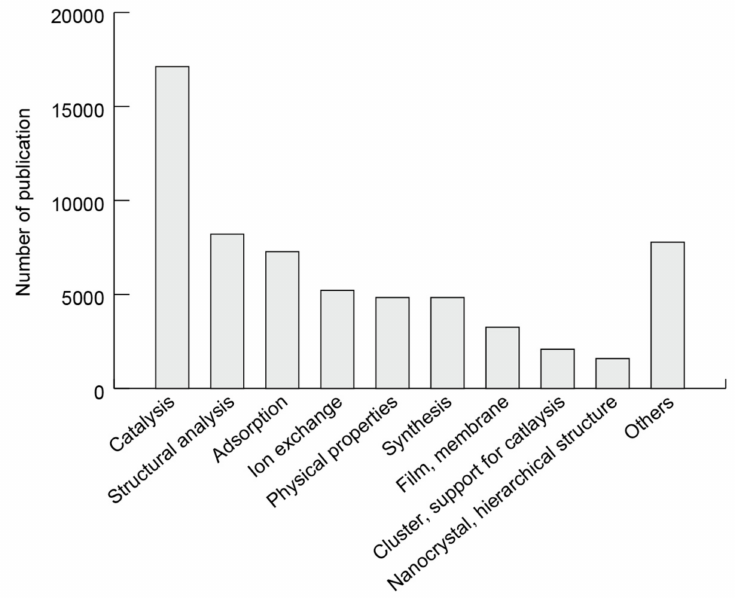
Figure 4. Research areas for zeolites from citation network